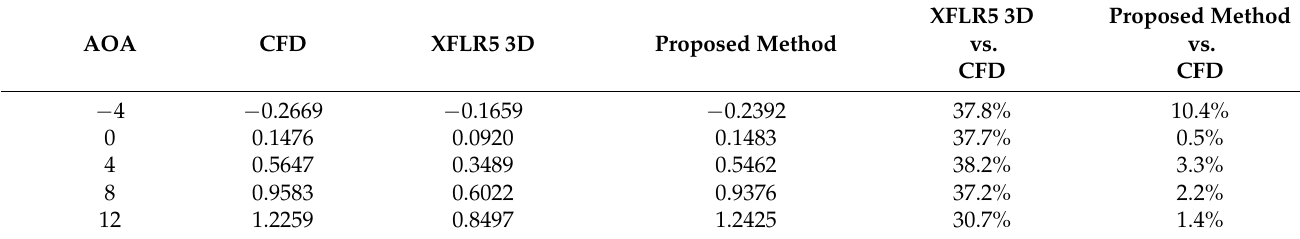
Table 3. Lift coefficient prediction comparison between the three methods.